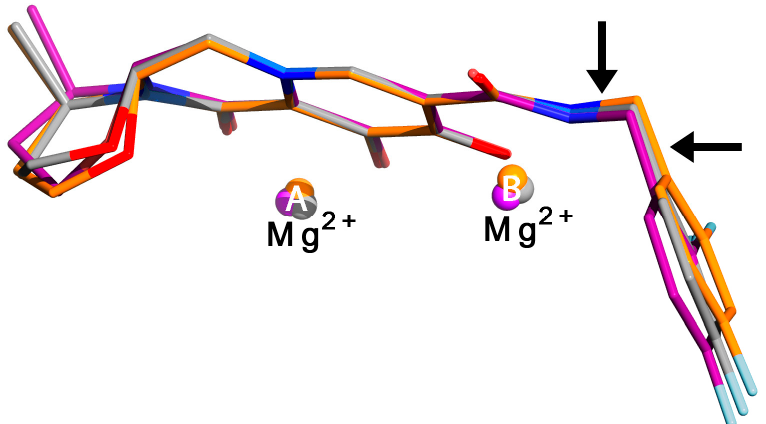
Figure 6. Strategic flexibility in DTG. DTG coordinates are superimposed from three structures of IN-orthologous prototype foamy virus (PFV) intasomes, showing the relative conformations of DTG observed in wild-type PFV (gray carbon atoms) and with resistance mutations corresponding to N155H (magenta carbon atoms, N224H in PFV) or Q148H (orange carbon atoms, S217H in PFV). Black arrows indicate the torsional angles in the flexible linker that are observed to rotate the most. Flexibility is also seen in the non-aromatic portion of the tricyclic ring system (left side of figure). The aromatic rings of the DTG coordinates were manually superimposed in Coot ® , and the figure was generated using PyMol ® , with annotation in Photoshop ® . Coordinates were taken from PDB accession IDs 3S3M (wild-type), 3S3O (PFV N224H), and 3S3N (PFV